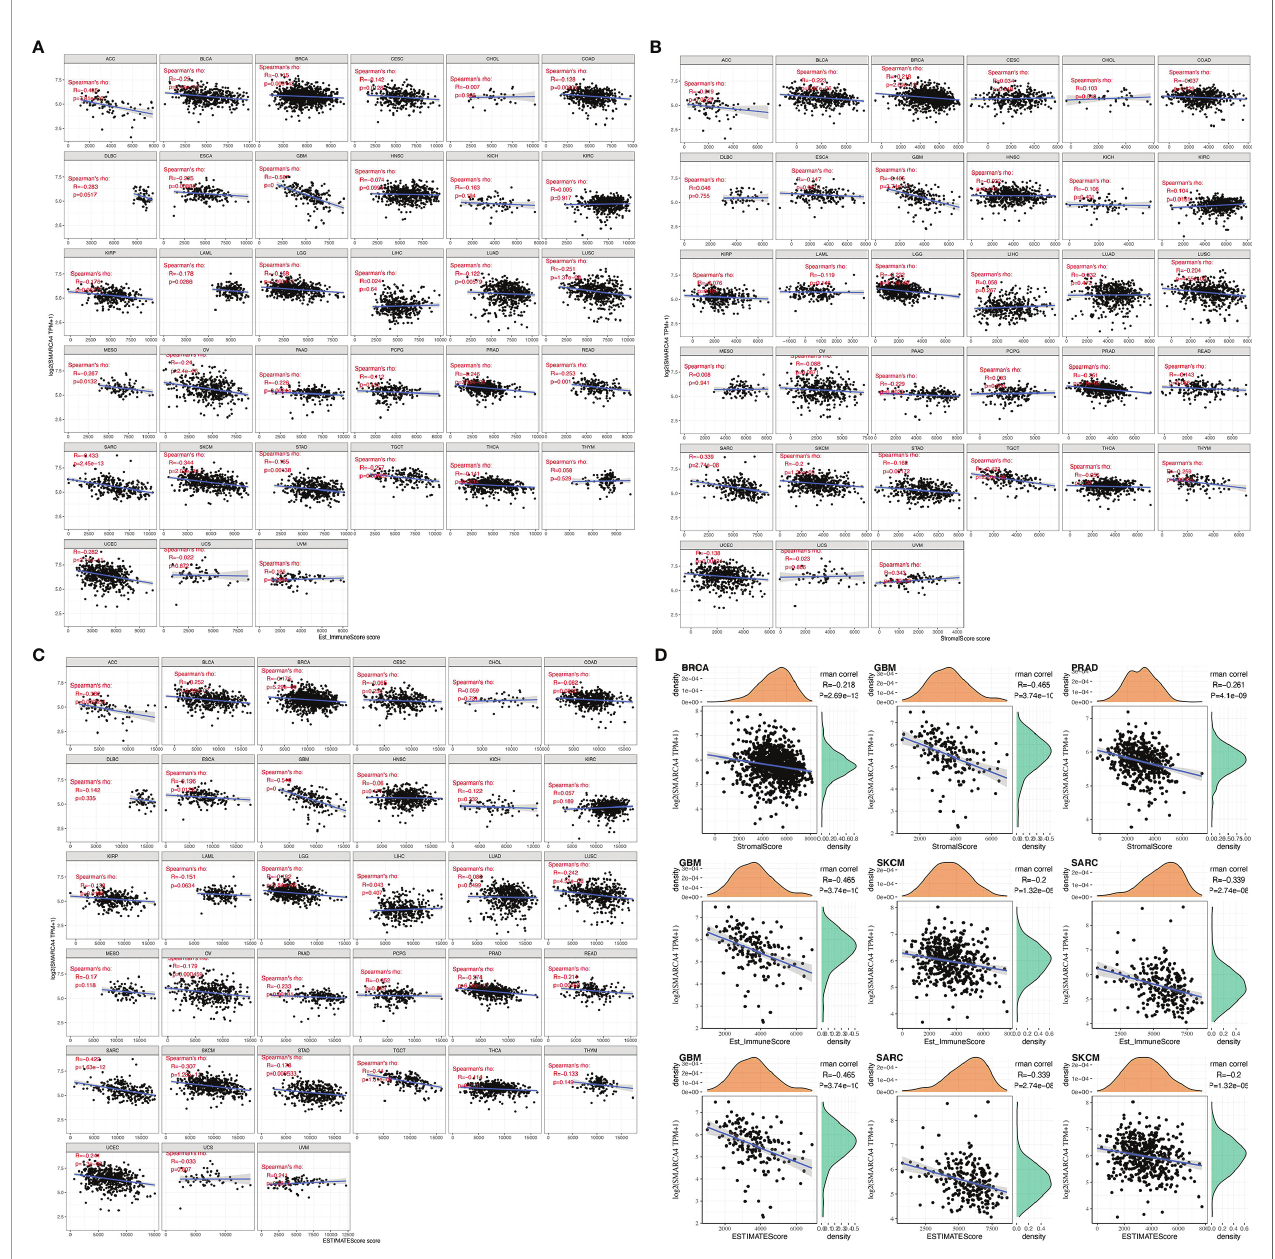
FIGURE 5 | Correlation of SMARCA4 expression with ImmuneScore, StromalScore, and ESTIMATEScore in various cancers. (A) Correlation of SMARCA4 expression with ImmuneScore. (B) Correlation of SMARCA4 expression with StromalScore. (C) Correlation of SMARCA4 expression with ESTIMATEScore. (D) Top 3 cancers by ImmuneScore, StromalScore, and ESTIMATEScore,